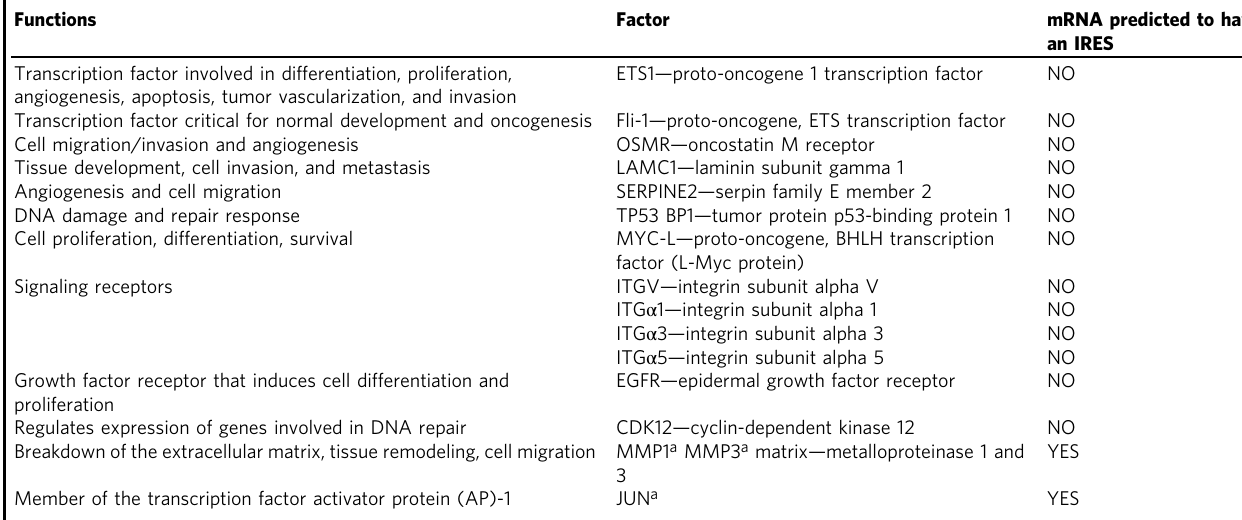
(Fig. 3e). eIF3d was retained in an electrophoretically stable and larger complex with DAP5 despite denaturation conditions. eIF3d is therefore a direct protein-binding partner of DAP5.